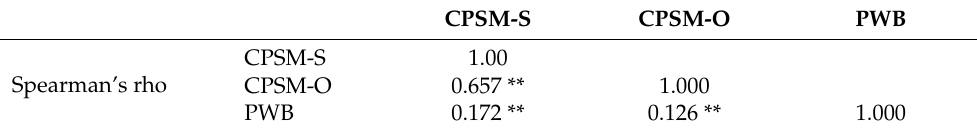
Table 2. Nonparametric correlations ( n = 523). CPSM-S CPSM-O PWB CPSM-S 1.00 Spearman’s rho